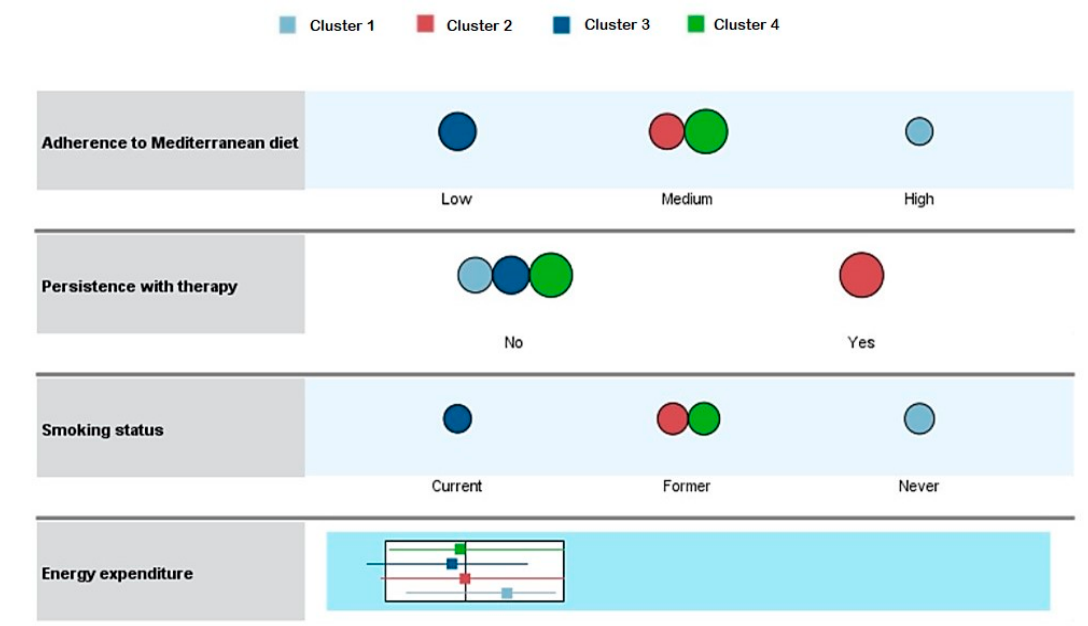
Figure 2. Comparison of the defining variables across the four established clusters.